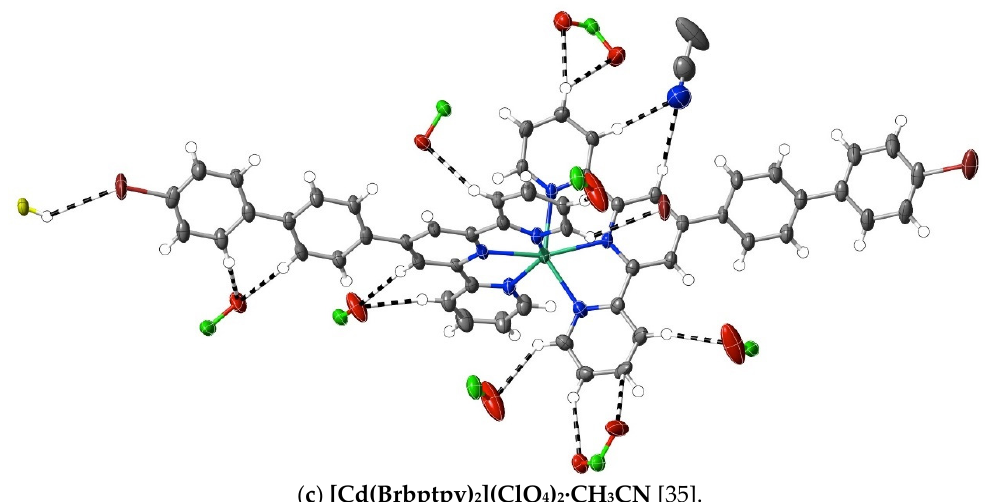
Figure 8. A comparison of interactions beyond dispersion in complexes of first- and second-row transition metal(II) ion complexes of Brbptpy . Chemistry 2021 , 3 , FOR PEER REVIEW